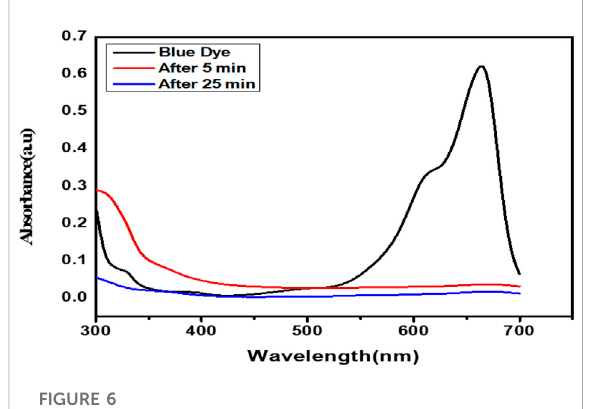
FIGURE 6 UV light of photodegradation of methylene